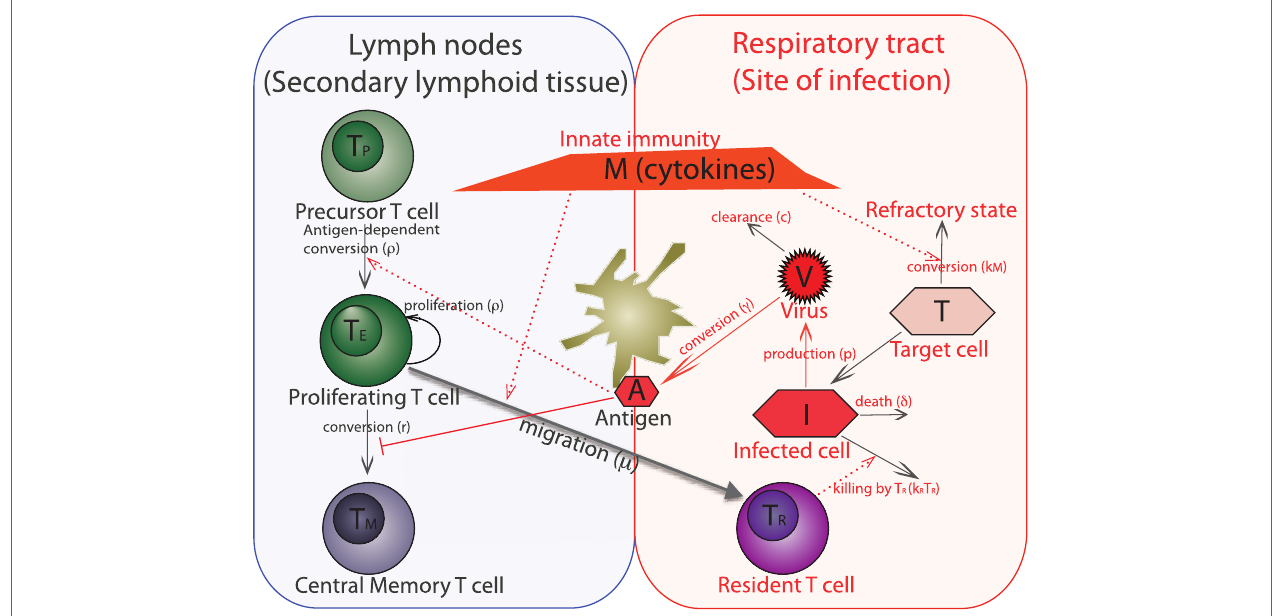
FIGURE 1 | Schematic of a within-host model of influenza infection . The model variables are target (uninfected) epithelial cells ( T ), infected epithelial cells ( I ), virus titer ( V ), innate immunity (cytokines) ( M ), antigen presented by dendritic cells ( A ), and four populations of CD8 T cells such as virus-specific precursor cells ( T P ), proliferating cells ( T E ), central memory cells ( T M ), and cells which are resident at the respiratory tract ( T R ). We do not separately model dendritic cells, instead we consider them together with antigen as one variable. An immune response to the influenza virus mainly occurs in the two compartments – lining of the respiratory tract, which is the actual site of infection and secondary lymphoid tissue (lymph nodes) where expansion of virus-specific T cells occurs.